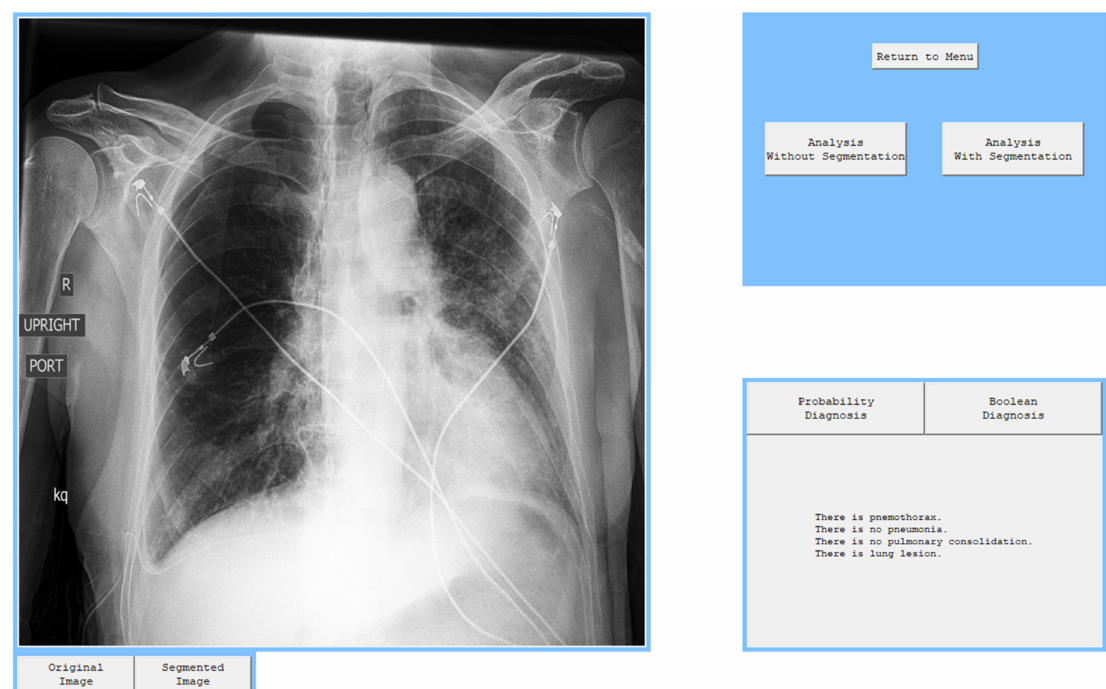
Figure 9. Diagnosis of a healthy patient.